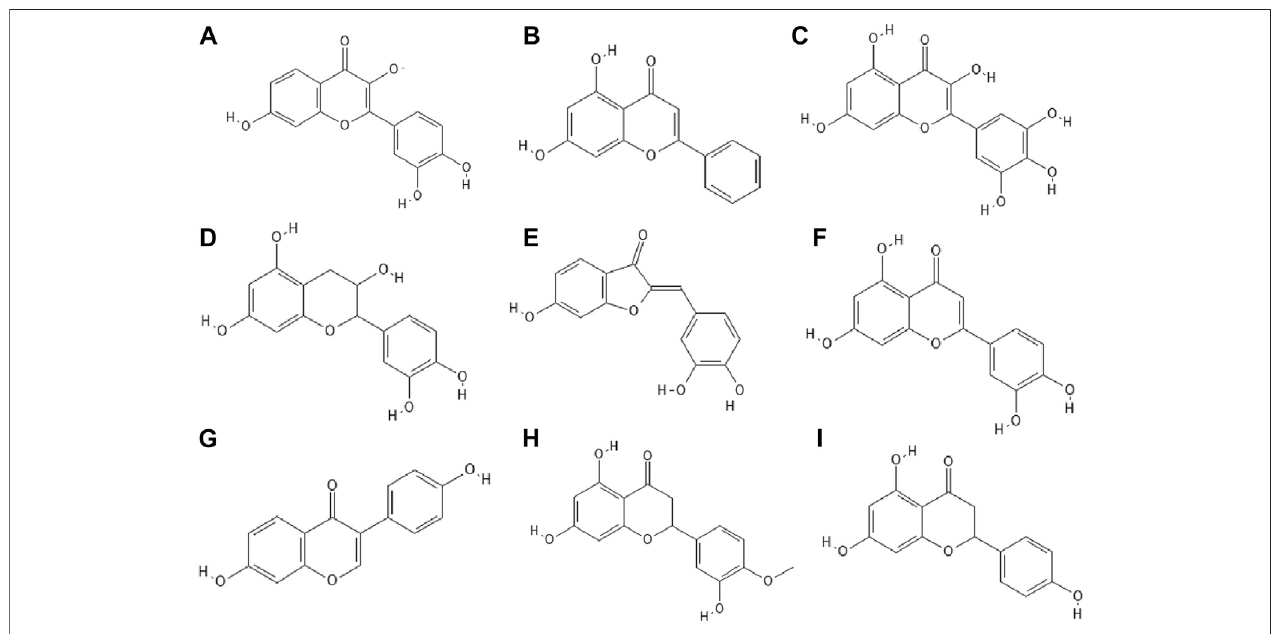
FIGURE 3 | The structures of: fi setin (A) , chrysin (B) , myricetin (C) , catechin (D) , sulfuretin (E) , luteolin (F) , daidzein (G) , hesperetin (H) , naringenin (I) .